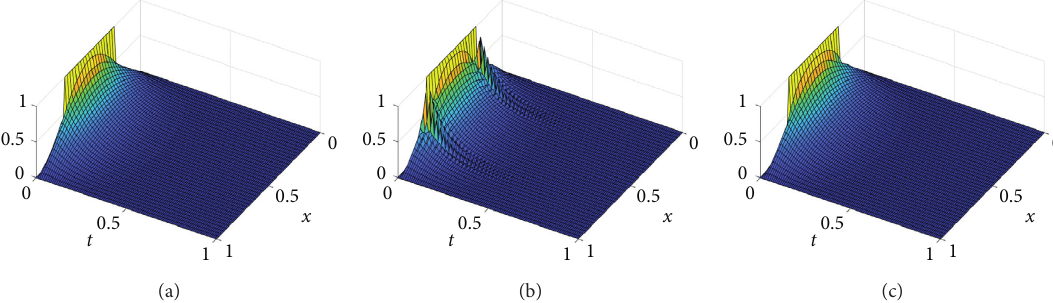
Figure 1: Propagation of the exact and numerical solutions for (15): (a) the exact solution and the numerical solution by (b) the CN method and (c) the variable- θ method [24], for 0 ≤ t ≤ T � 1 . 0, when Δ t � 0 . 01 and Δ x � 0 . 025.